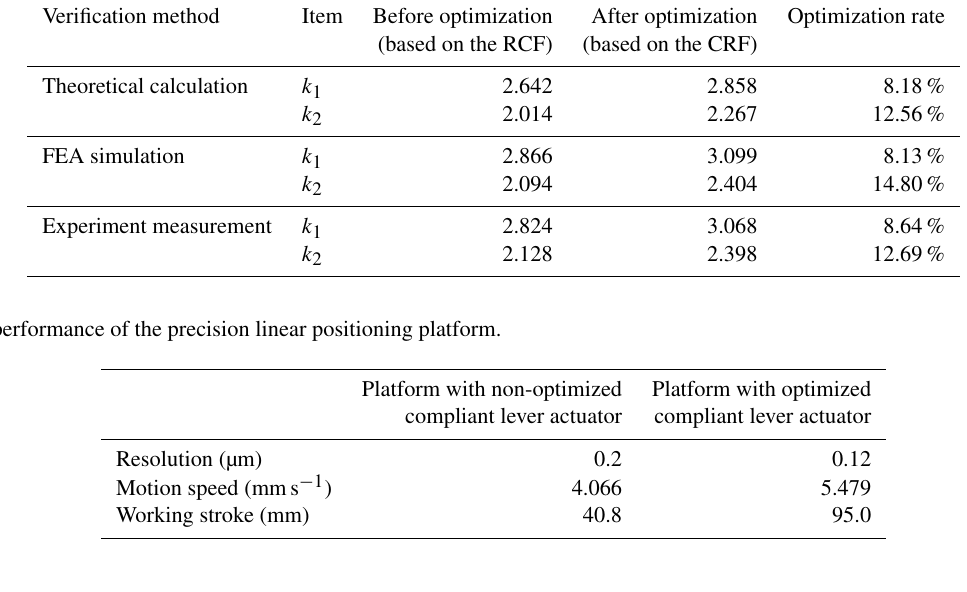
Table 2. Magnification ratio comparison.